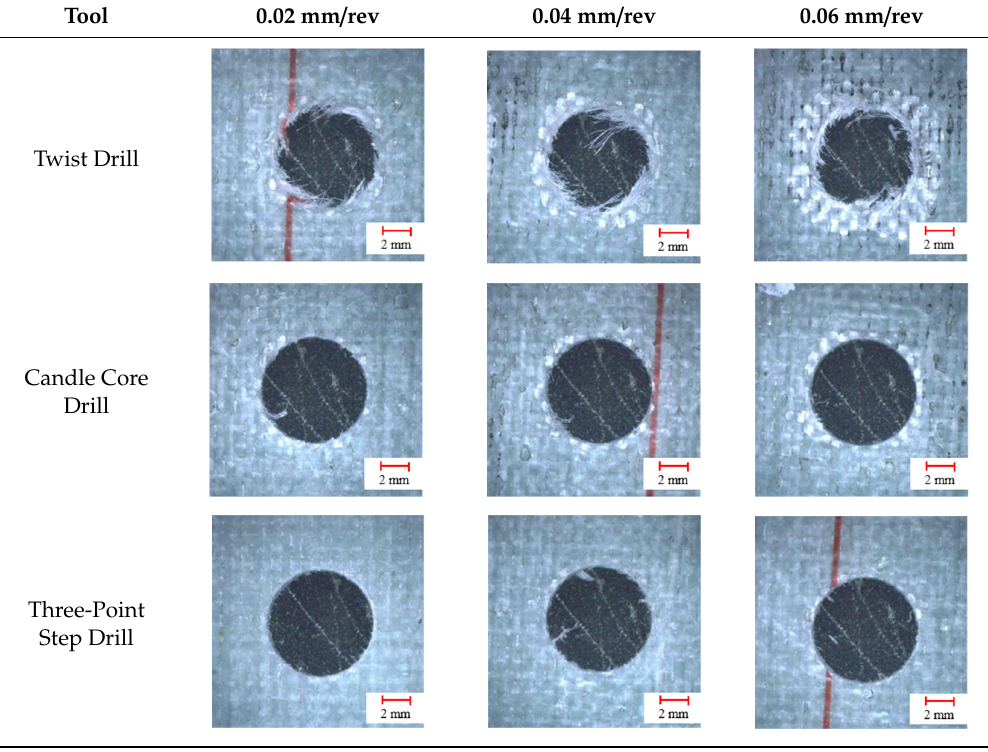
Figure 8. Microstructures and SEM images of the drill-exit. ( a ) Microstructures of the exit by Alicona; ( b ) Delamination SEM images of drill-exit.